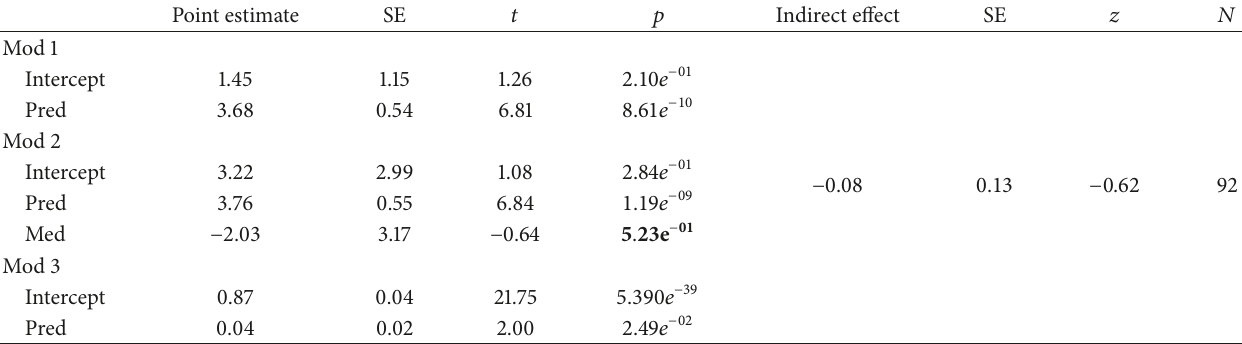
Table 7: Mediation analysis of the directionless similarity as mediator of the relationship between simplicity of information structure and the number of